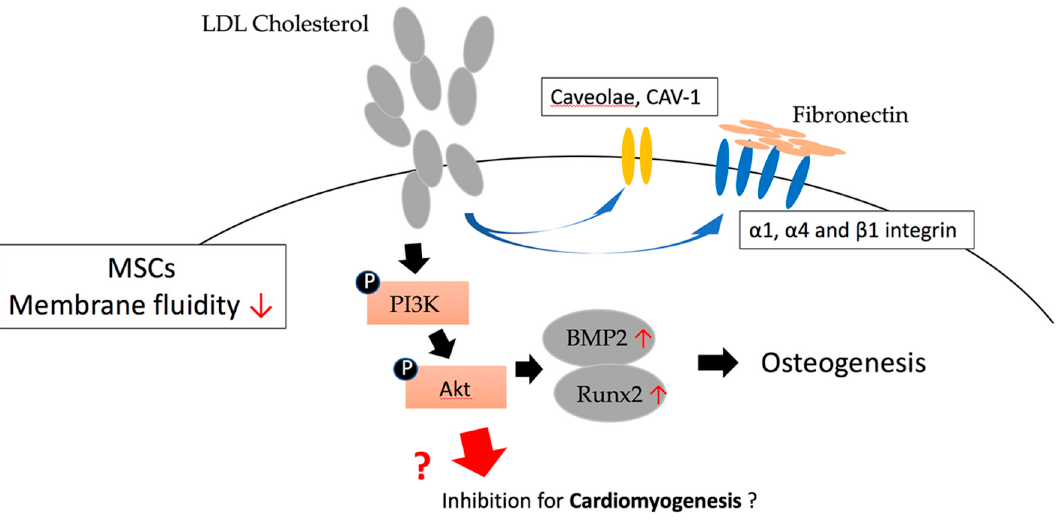
Figure 4. The effect of low ‐ density lipoproteins (LDL) cholesterol in regulating MSC differentiation through the phosphorylation of PI3K / Akt through the phosphorylation of PI3K/Akt pathway.